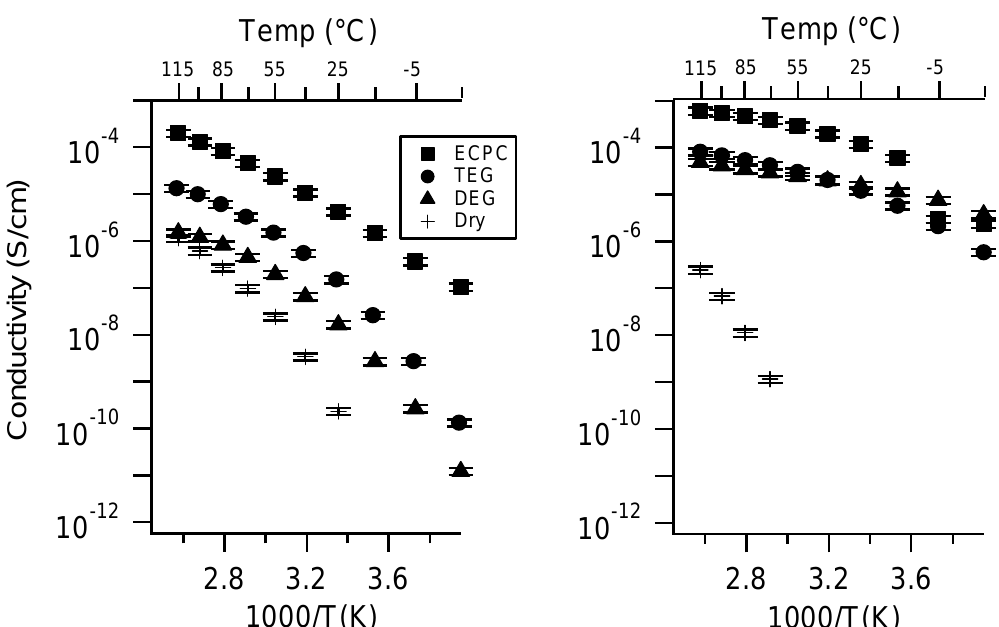
Figure A26. Conductivity as a function of solvent for PEGDMA1000_med_SSK (left) and PTHFDA1000_med_STFSIK (right) SIPEs. Temperatures ranged from − 20 °C to 115 °C. Note that there may be a non-negligible fraction of electronic conductivity in conditions where conductivity of less than 10 − 9 S/cm is reported.